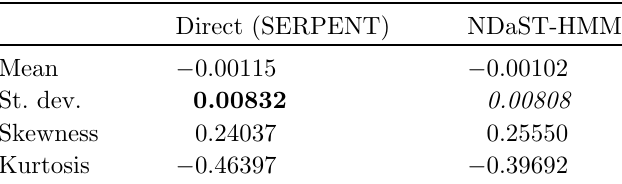
Fig. 2. Comparison of D k eff for both NDaST-HMM and direct calculation with SERPENT. Table 1. Comparison of D k distribution statistics for eff TENDL-2014 random fi